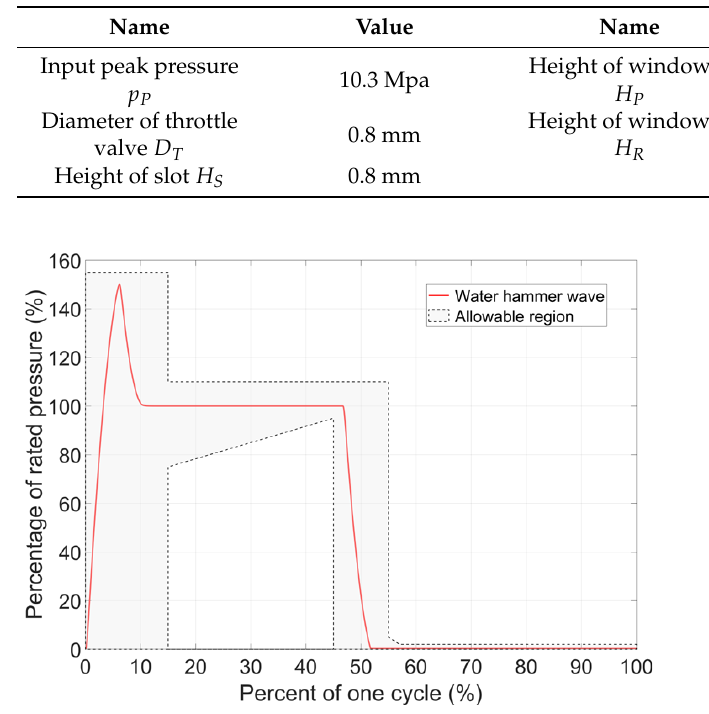
Figure 7. Water hammer wave produced by using the optimized